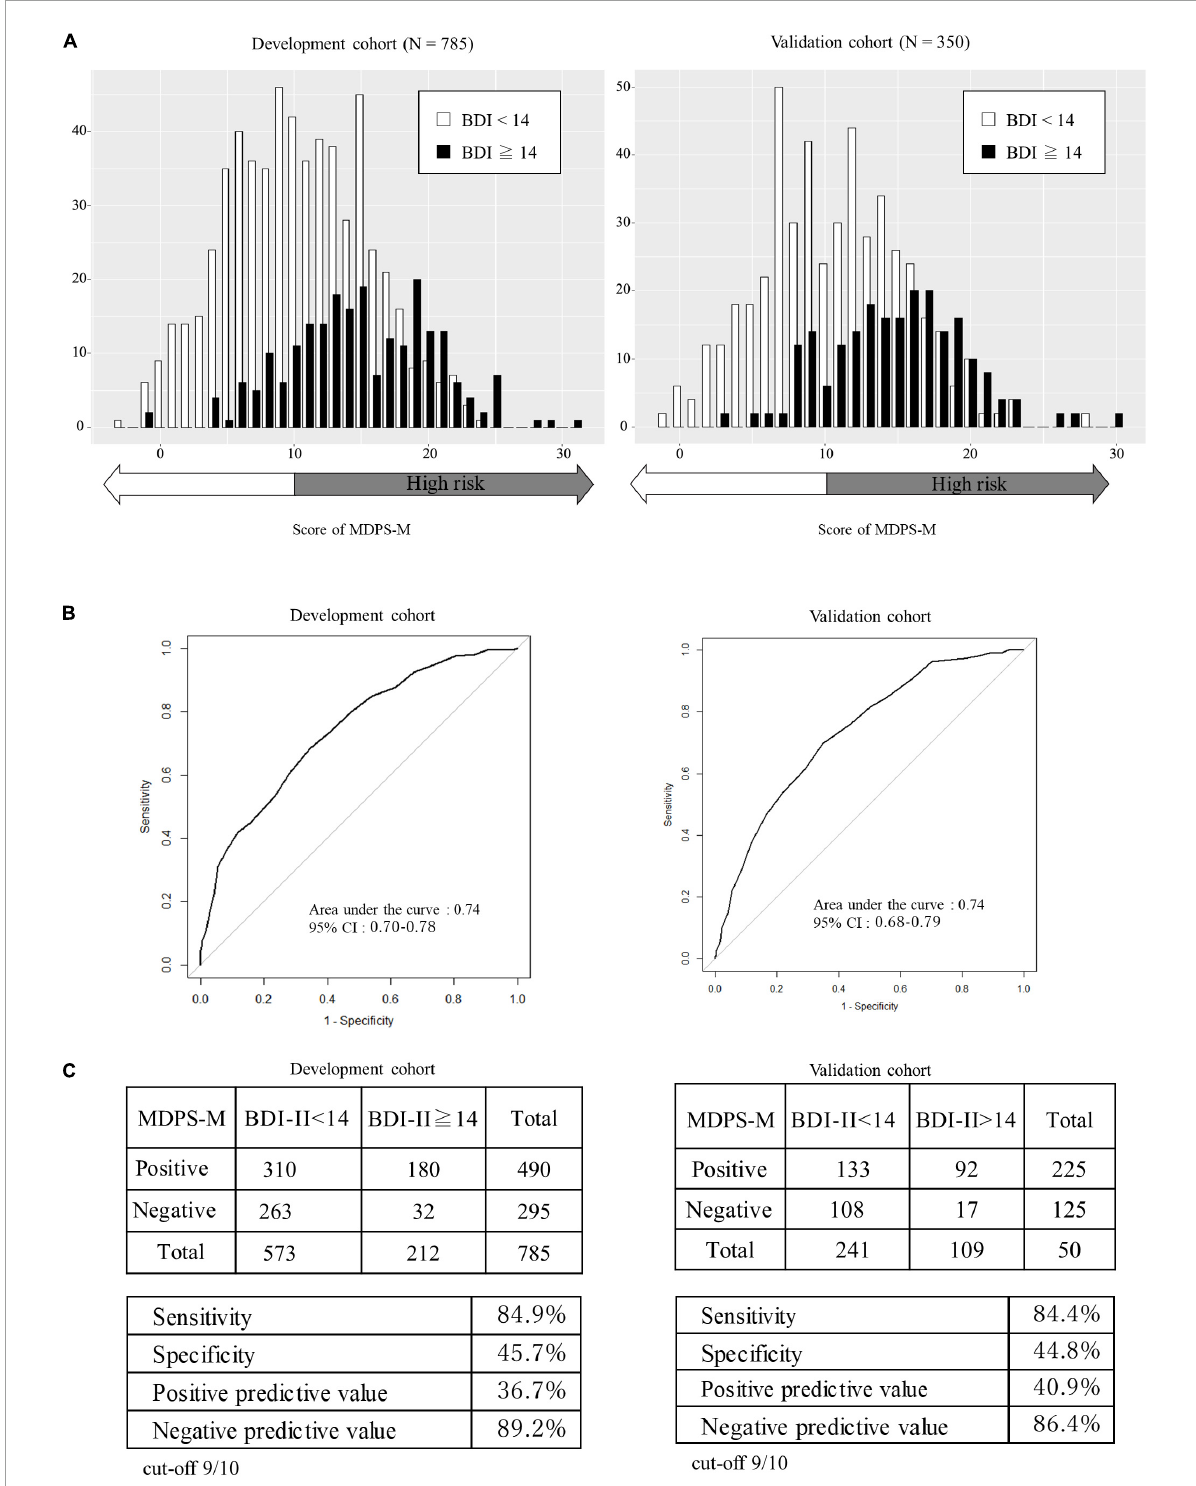
FIGURE3 Score distribution, discrimination capability, and diagnostic accuracy of the MDPS-M in the development cohort and the validation cohort. (A) Score distribution of the MDPS-M in the development cohort and the validation cohort. (B) Discrimination capacity of the MDPS-M for the identification of depression based on the BDI-II by ROC curves. (C) Sensitivity, specificity, positive predictive value, and negative predictive value for a score of 10 or more for a high risk for depression. AUC, area under the curve; MDPS-M, multidimensional physical scale for mothers; BDI, beck depression inventory; ROC, receiver-operating